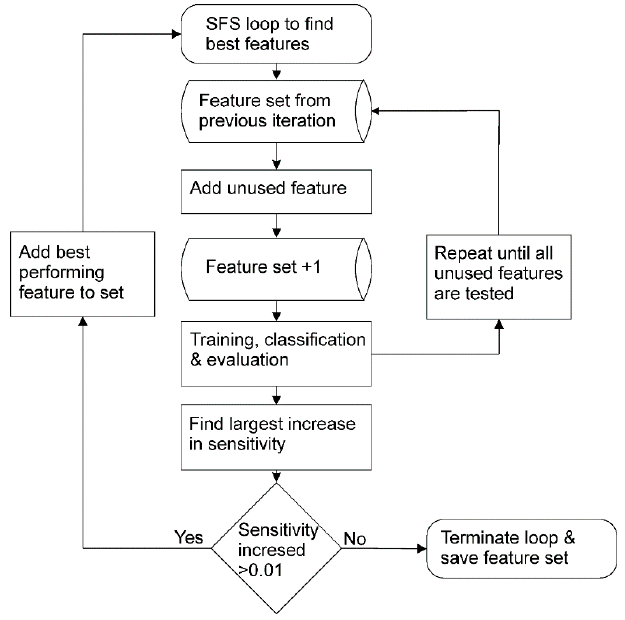
Figure 2. First feature selection scheme using correlation analysis, ANOVA, and backwards sequential feature selection with the number of features removed in each step.